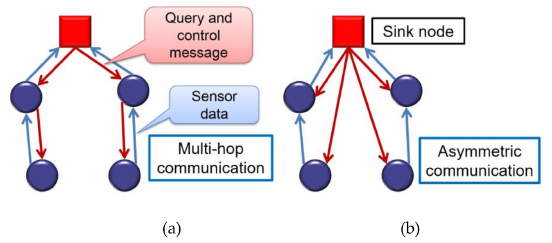
Figure 1. Communication paths: ( a ) symmetric multi-hop communication and ( b ) asymmetric